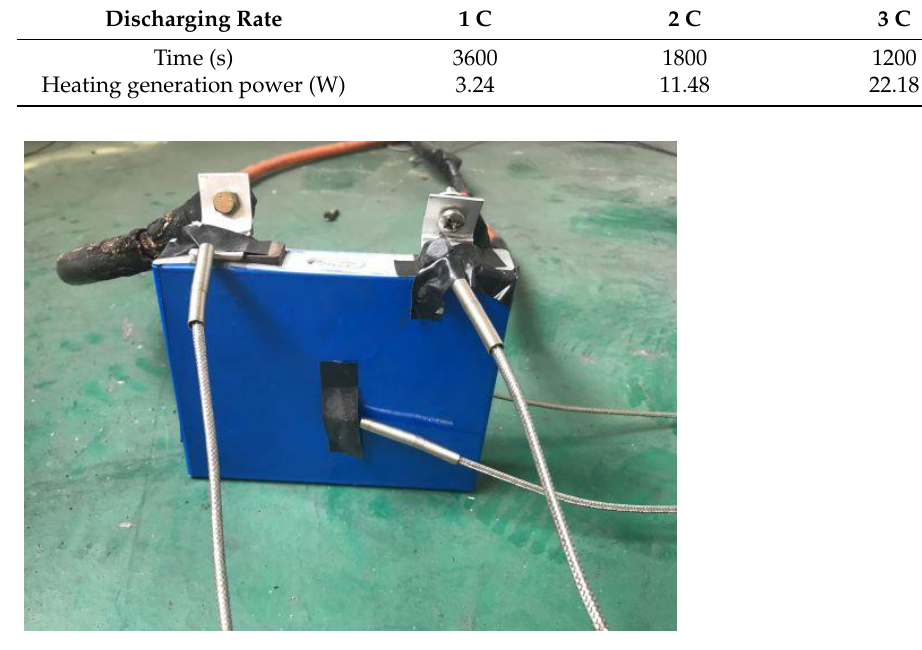
Figure 1. Experiment setup.